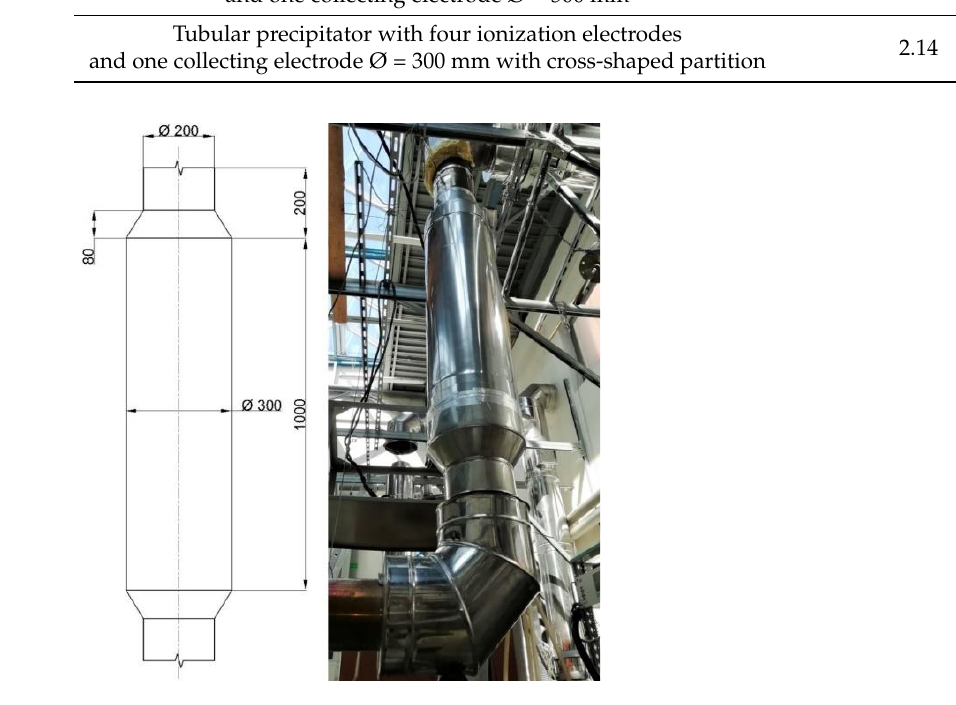
Figure 2. The geometry of the precipitator.